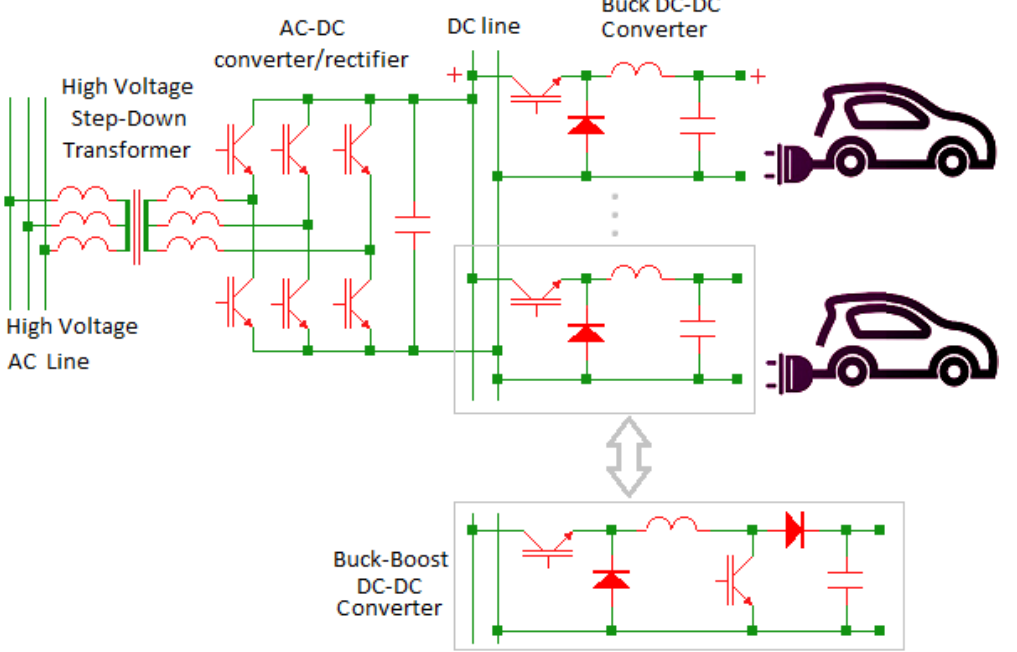
Figure 1. A fast-charge station with the main elements of direct current–direct current (DC–DC)